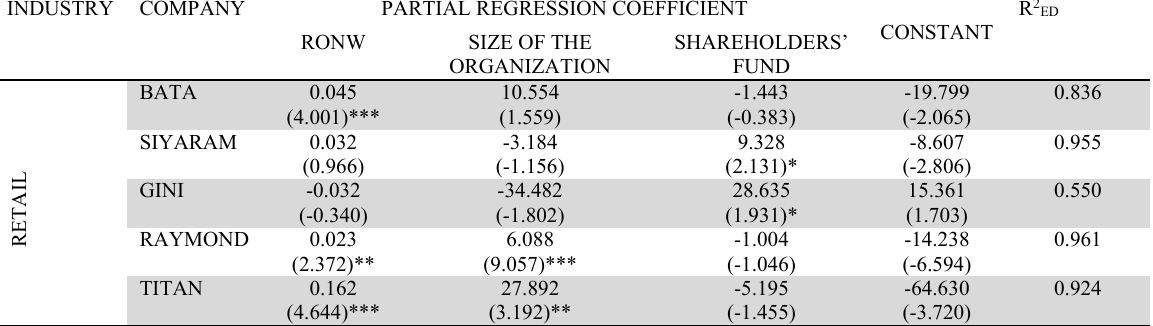
Analysis of Multiple Regression of CCC on RONW, Size of Org. and shareholders’ Fund of the Selected Companies of Retail